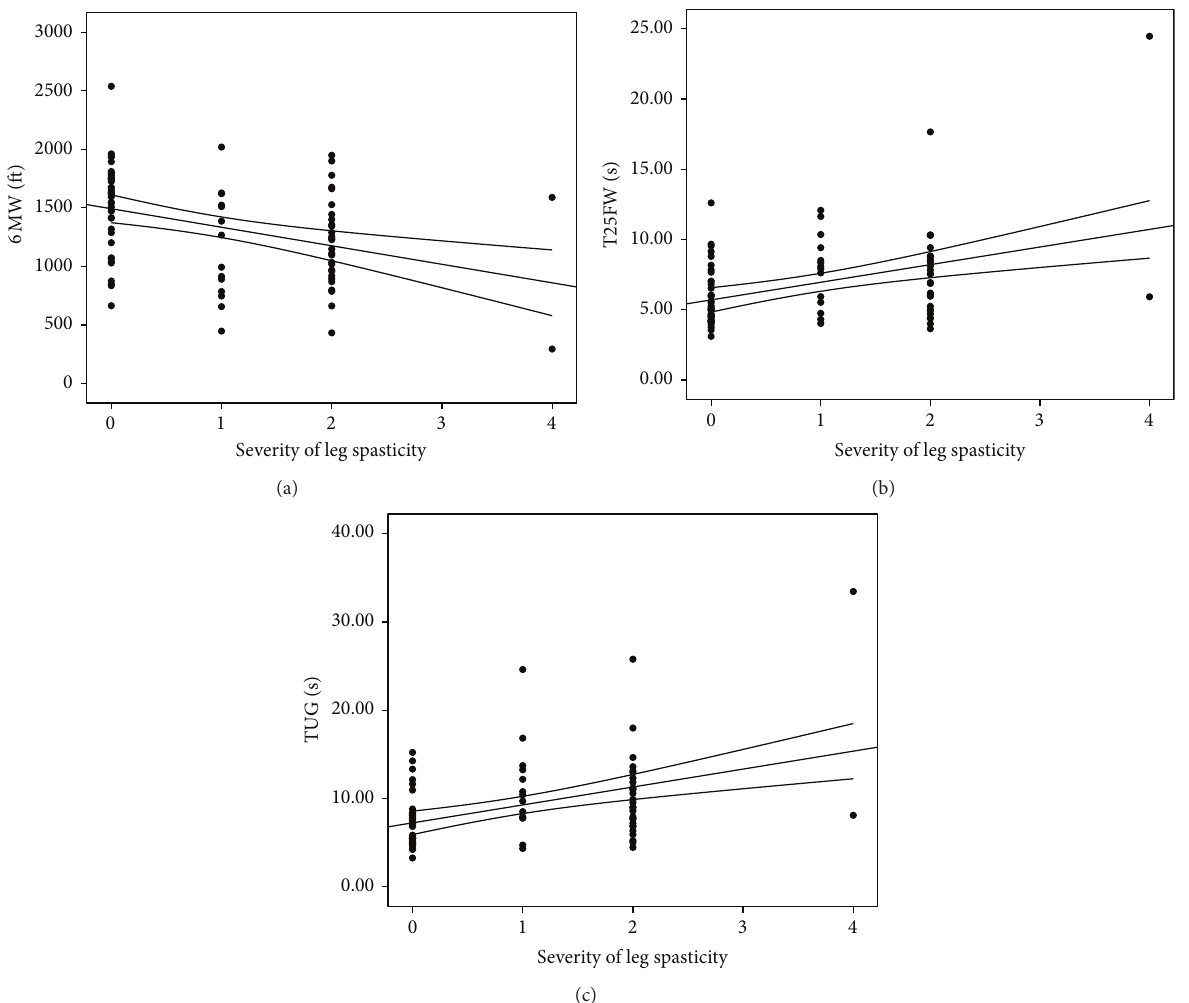
Figure 1: Scatter plots of the association between severity of leg spasticity and walking performance measured by the 6-minute walk (6MW), time 25 foot walk (T25FW), and timed up-and-go